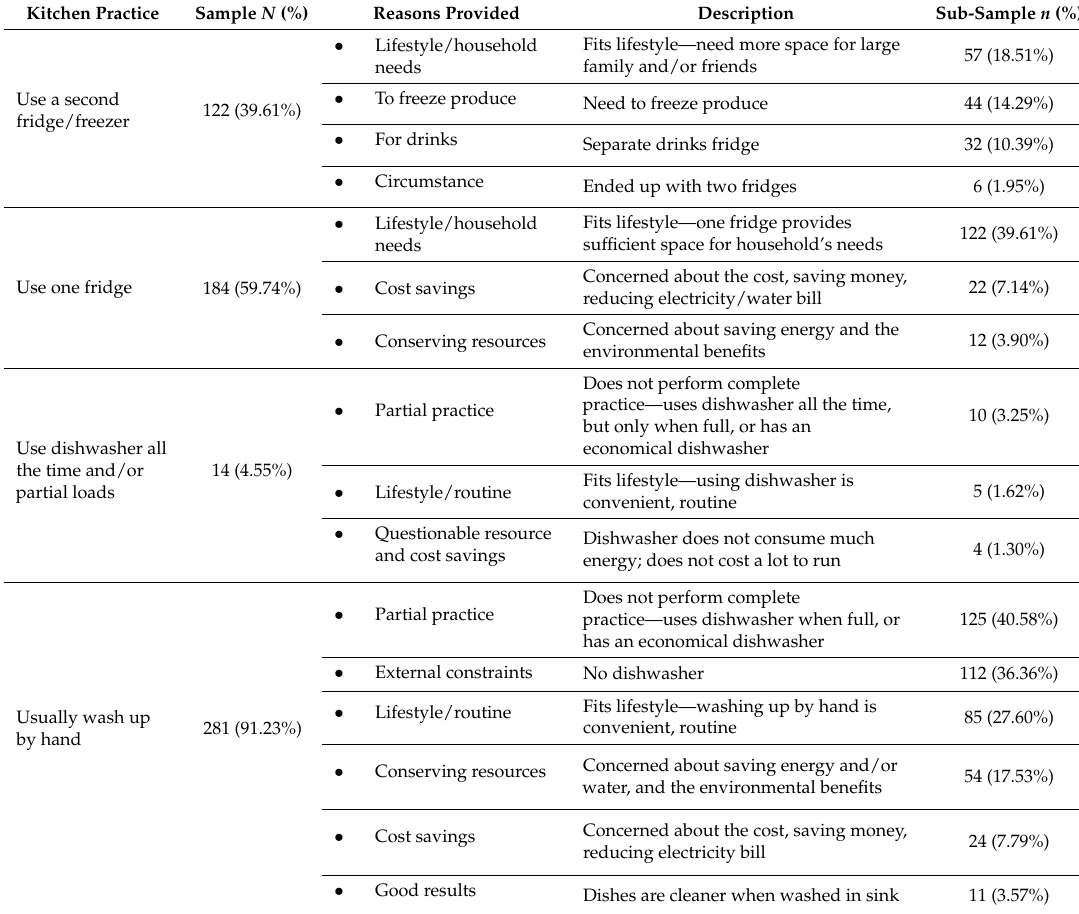
Table 2. Reasons given for engaging in energy-efficient and energy-inefficient practices in the kitchen domain ( N =